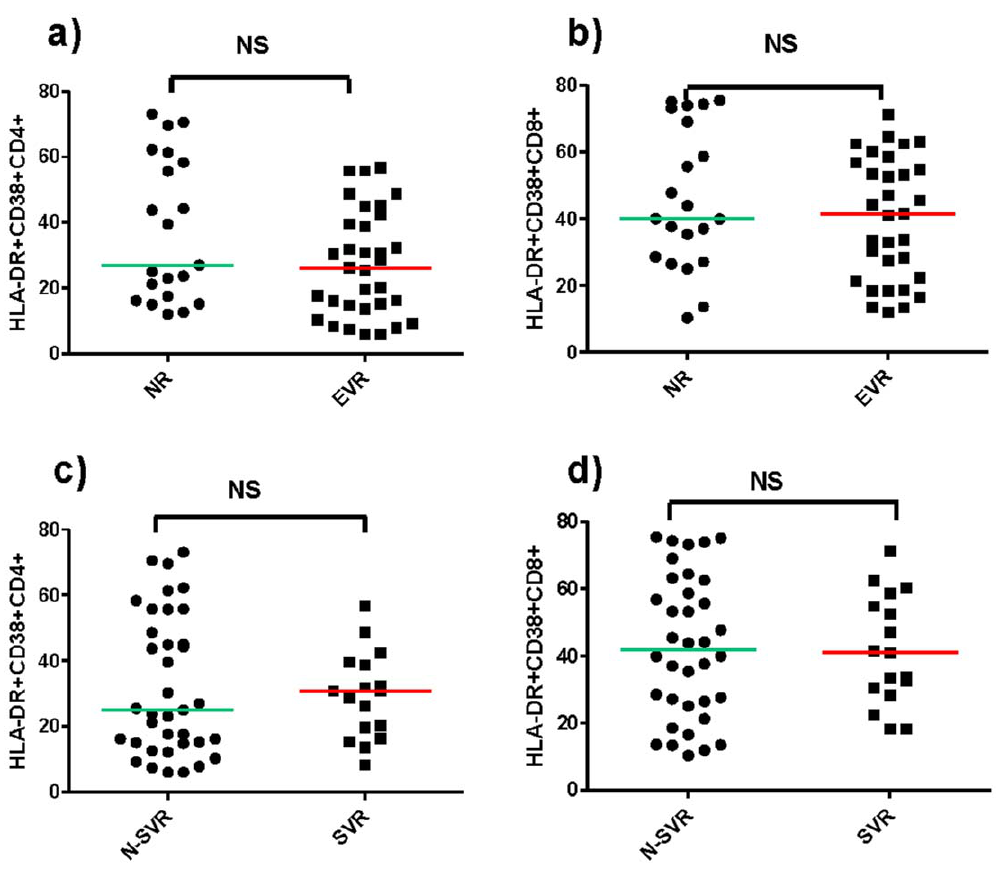
Figure 3. Activated HLA-DR + CD4 + and CD8 + T-cells according to EVR and SVR. a ) -b ) Activated HLA-DR + CD4 + and CD8 + T-cells were compared between patients with early virological response [EVR, i.e. undetectable serum HCV-RNA ( , 50 IU/mL) or $ 2 log 10 reduction from baseline after 12 weeks of therapy], and Null Responders (NR) (i.e. serum HCV-RNA $ 50 IU/mL and , 2 log 10 reduction from baseline). c ) -d ) Activated HLA- DR + CD4 + and CD8 + T-cells were compared between patients with sustained virological response [SVR, i.e. undetectable serum HCV-RNA ( , 50 IU/ mL) 24 weeks after the end of a full course of 48 or 72 weeks of anti-HCV treatment, according to genotype], and N-SVR subjects. Each point represents the value from one subject’s plasma. Activated HLA-DR + CD4 + and CD8 + T-cells % values are presented. p-values were assessed by Mann Whitney U test. p . 0.05 was considered non significant (NS).